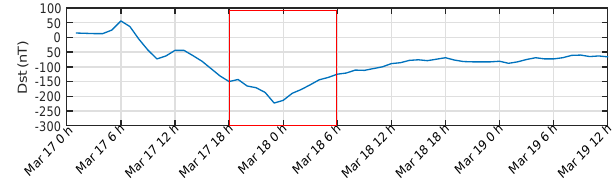
Figure 12. Dst index from 17 to 19 March 2015.